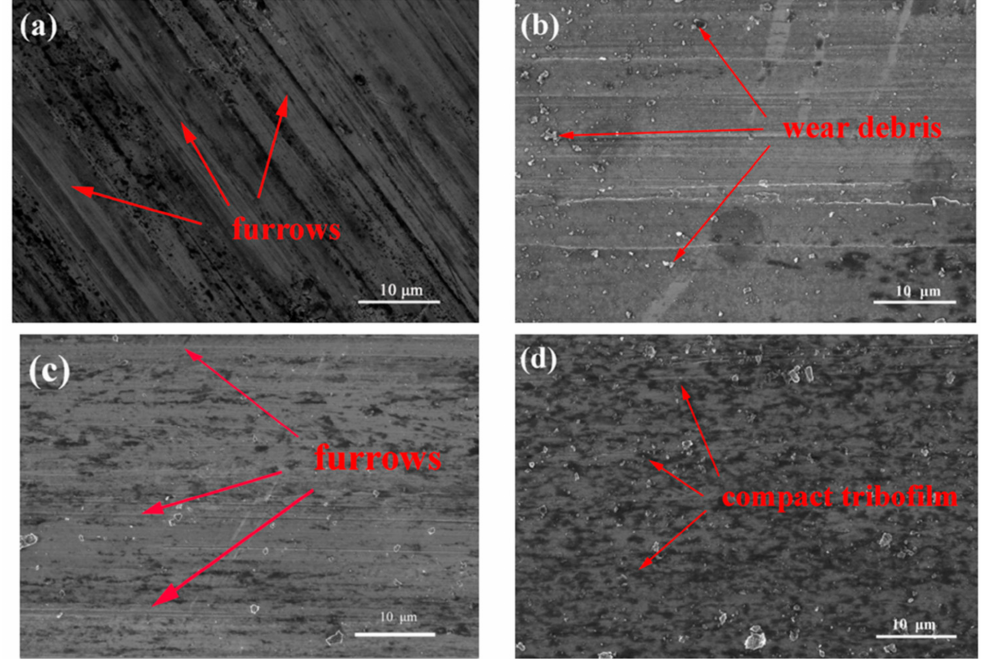
Figure 7. FESEM images of the worn surfaces on the magnesium alloy lubricated by: ( a ) base oil, ( b ) 0.1 wt % SiO 2 nanolubricants, ( c ) 1.0 wt % MoS 2 nanolubricants, and ( d ) SiO 2 :MoS 2 (0.1:1.0) hybrid nanolubricants (3 N, 0.08 m/s, 0.5